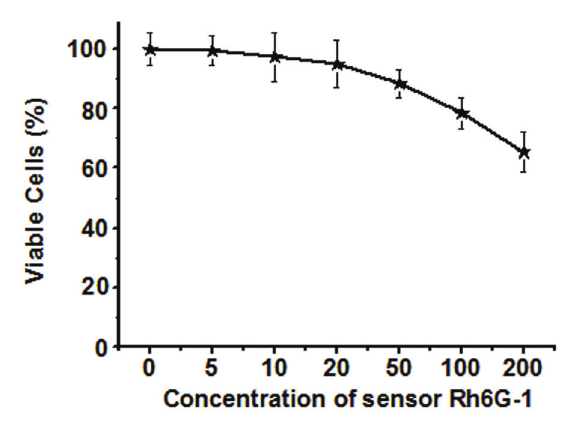
Figure 7 : Cytotoxicity assay of sensor Rh6G-1 at different concentrations (a: 0 μΜ; b: 5 μΜ; c: 10 μΜ; d: 20 μΜ; e: 50 μΜ; f: 100 μΜ; g: 200 μΜ) for HeLa cells.